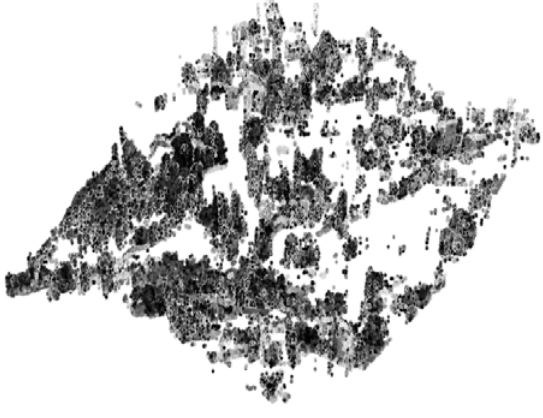
Figure 11. 3D vegetation